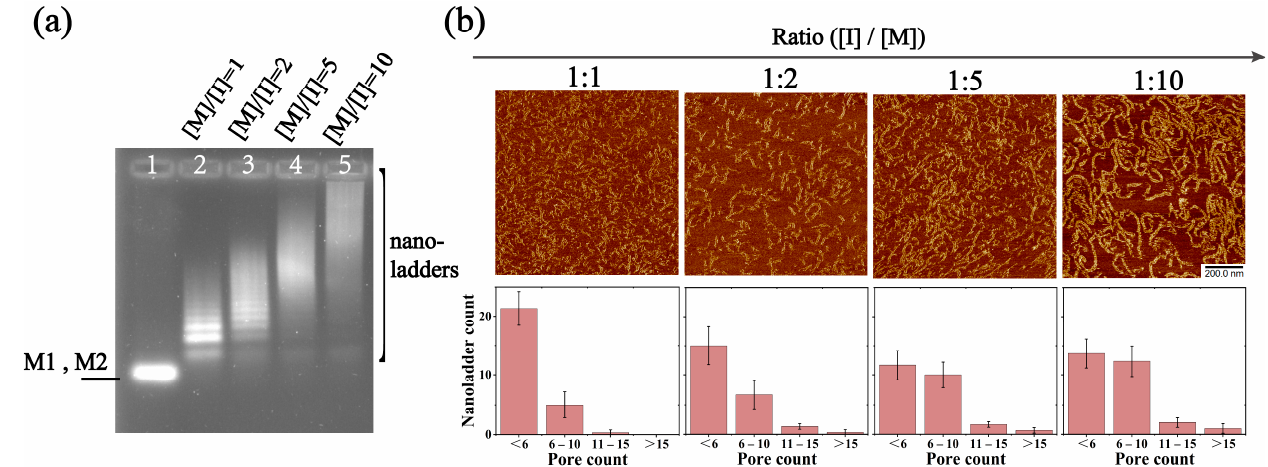
Figure 5. Analysis of different molar ratios between the initiator and assembly motifs M1 and M2. ( a ) Native agarose gel (1.5%) electrophoresis of different molar ratios between initiator and assembly motifs. The composition of the lanes is marked on the sides of the gel, and the molar ratio of the motif to the initiator corresponding to each lane is marked at the top of each lane. Lane 1 indicates that in the absence of the initiator, M1 and M2 are mixed in equal proportions and then spotting is performed immediately. Lane 2 to lane 5 represent the assembly of initiator and motif at different molar ratios. The concentrations of M1 and M2 are both 250 nM, and varying concentrations of initiator are added according to the indicated molar ratio. ( b ) AFM images and length statistics of DNA nanoladders. The proportion of the initiator gradually decreases from left to right. The con ‐ centrations of M1 and M2 are both 500 nM, and varying concentrations of the initiator are added according to the indicated molar ratio. All the scanned samples were diluted to 200 nM. All the data in the bar chart are repeated three times. For gel electrophoresis and AFM, all ratios of the reaction solutions are reacted at room temperature (25 °C) for 16 h.